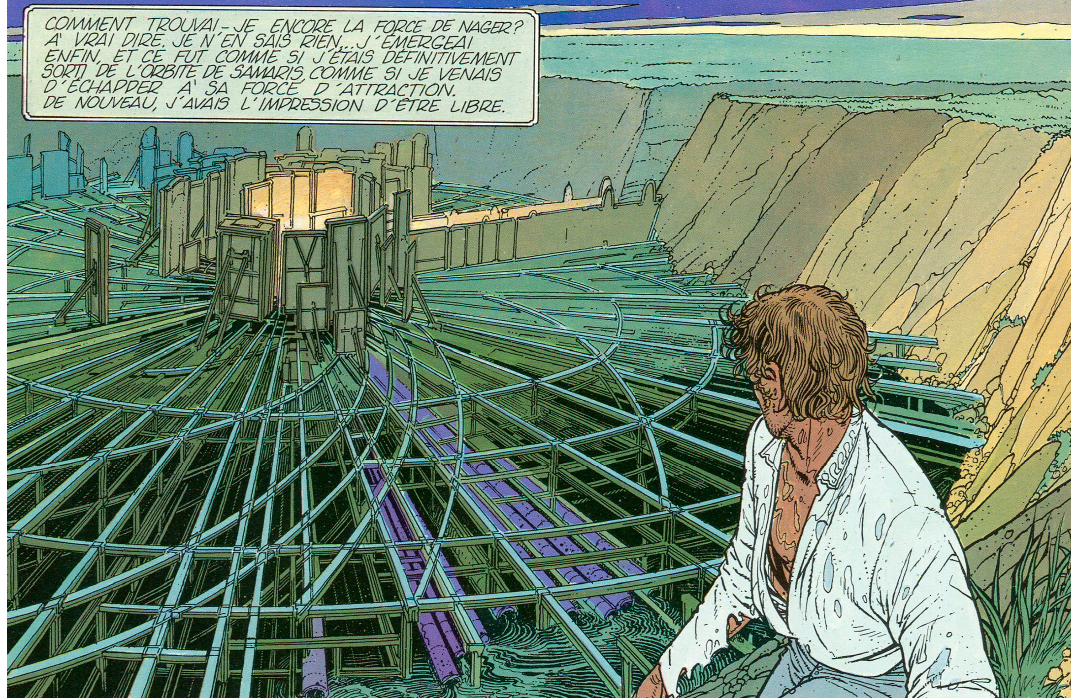
Figure 4. Francois Schuiten, Benoit Peeters, Les murailles de Samaris,